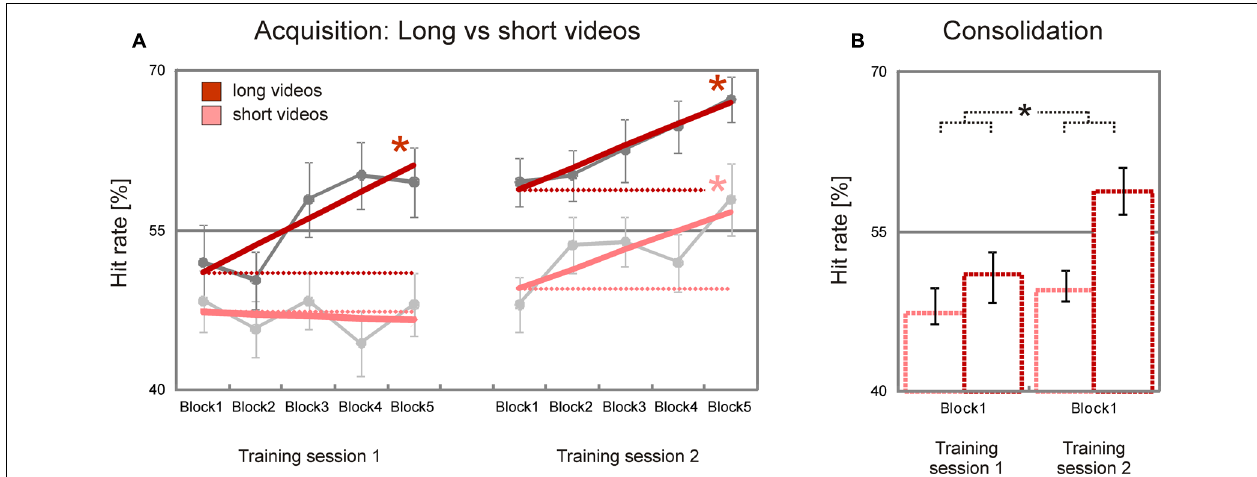
FIGURE 3 | Improvement of facial emotion recognition accuracy (long vs. short videos). Participants showed a significant linear increase in emotion recognition accuracy within both training sessions for long videos but not for short videos; for short videos a significant increase in emotion recognition accuracy was observed only in the second training session (dark/bright bold red lines in A ). In line with this, emotion recognition accuracy increased significantly from the first block of the first training